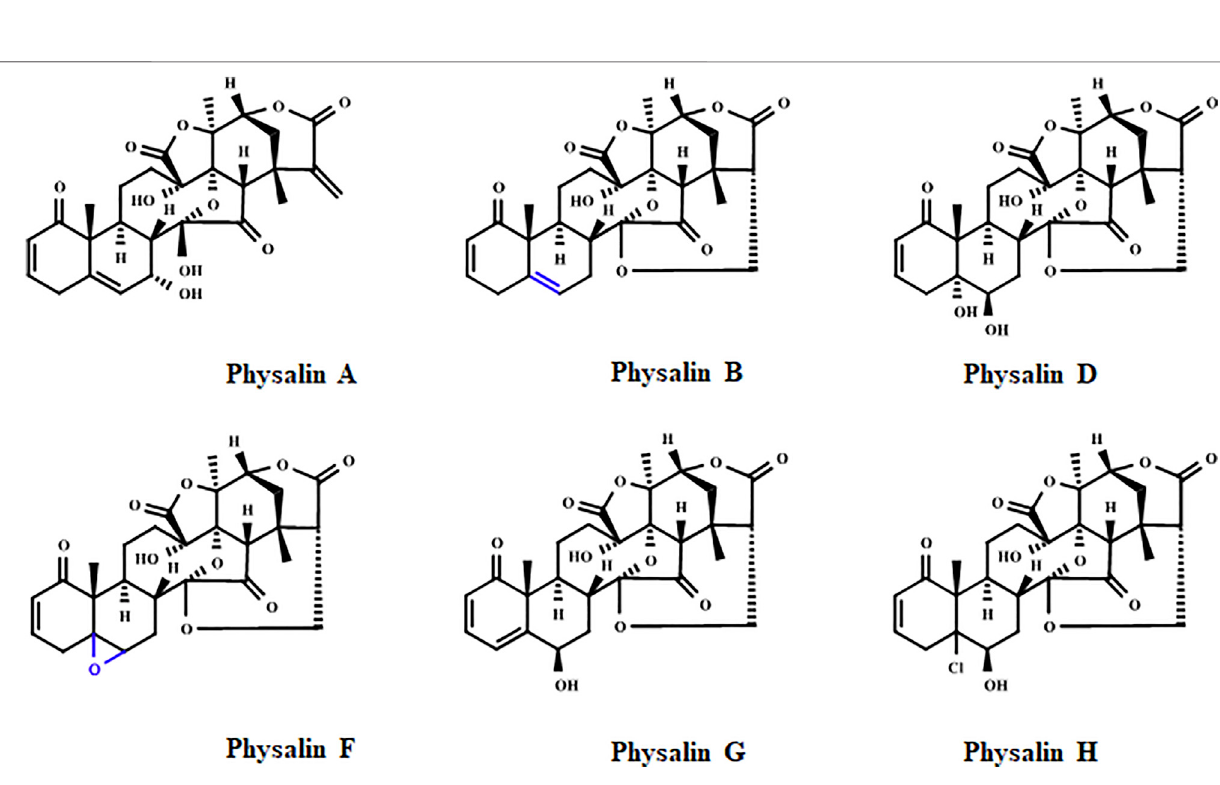
Frontiers in Pharmacology |